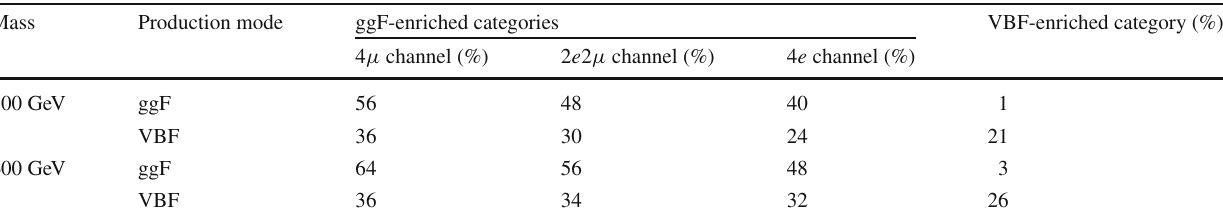
Table1 Signalacceptanceforthe (cid:3) + (cid:3) − (cid:3) + (cid:3) − analysis,forboththeggF and VBF production modes and resonance masses of 300 and 600 GeV. The acceptance is defined as the ratio of the number of reconstructed